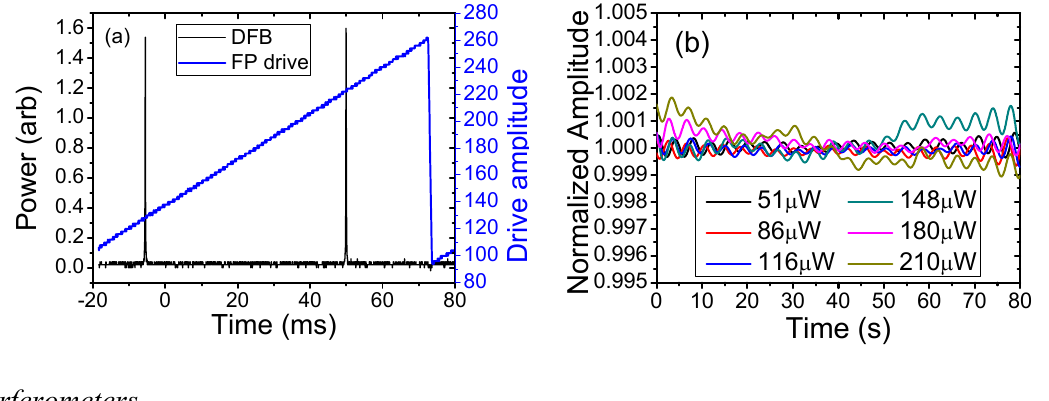
Figure 1. ( a ) Longitudinal mode structure of DFB acquired using a scanning Fabry-Perot (FP) and an oscilloscope; ( b ) Amplitude fluctuations in DFB for varying power measured directly on an oscilloscope.